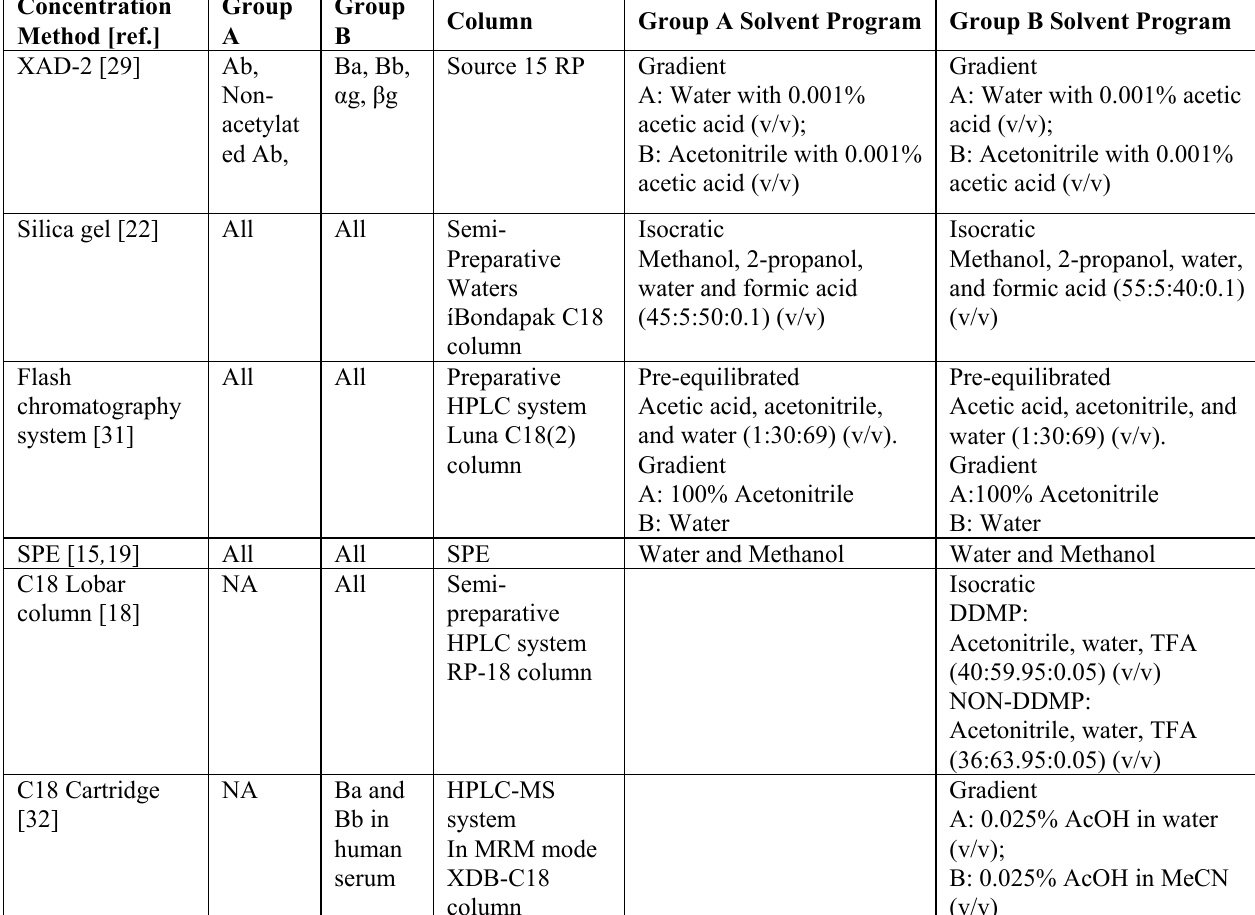
Table 1. Concentration, HPLC Quantification Methods of Soyasaponins.